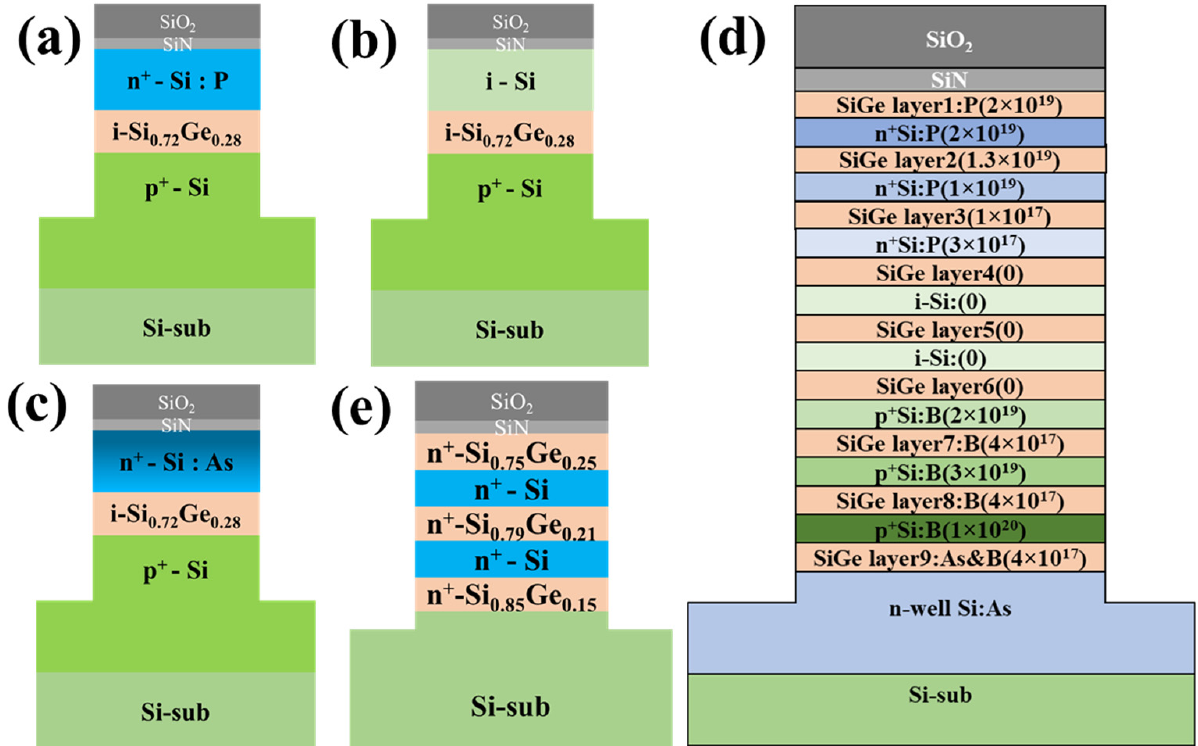
Figure 1. Scheme of the laminated structure with a lateral opening: ( a ) in situ n + -Si/i-SiGe/p + -Si; ( b ) i-Si/i-SiGe/p + -Si; ( c ) implanted n + -Si/i-SiGe/p + -Si; ( d ) SiGe/Si multilayers with different doping types; ( e ) SiGe/Si multilayers with different Ge fractions.